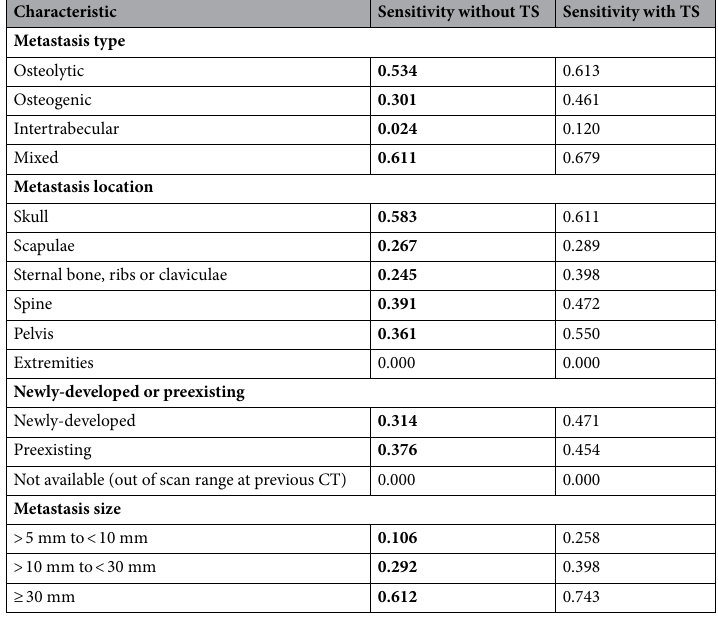
Table.4. Subgroup results based on metastases characteristics. Sensitivity without and with TS for each subgroup of the 160 bone metastases is shown. Cells for which result is inferior in a comparison between without and with TS are bold. CT computed tomography, TS temporal